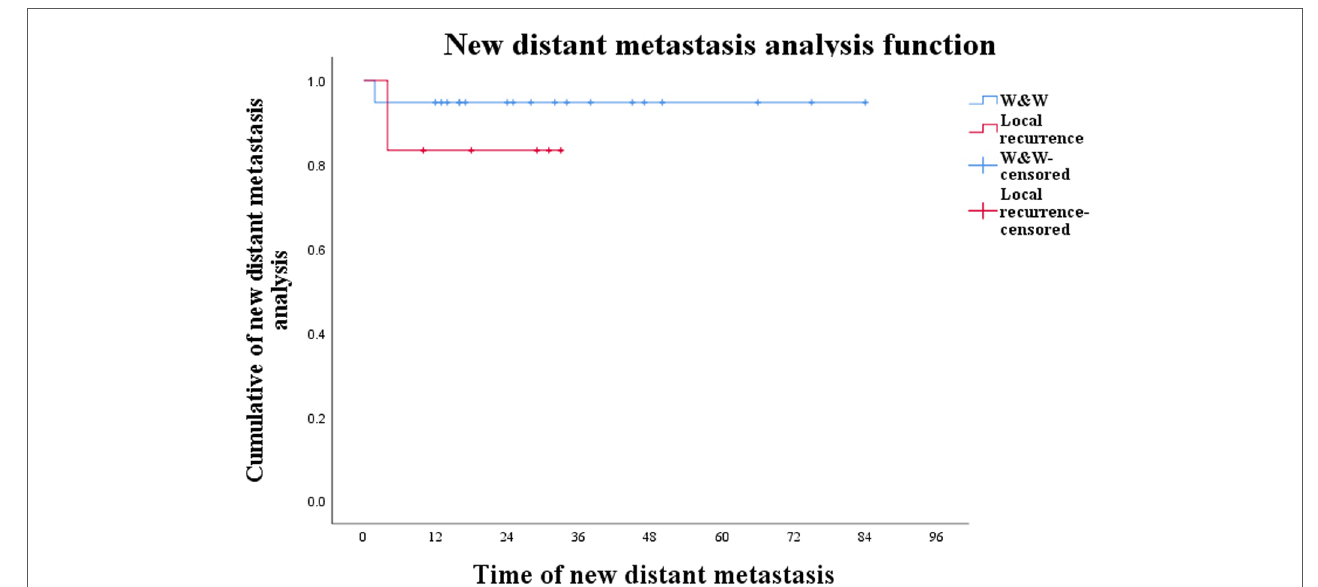
FIGURE 3 Curve of new distant metastases in W&W patients and local-recurrence patients during W&W ( P